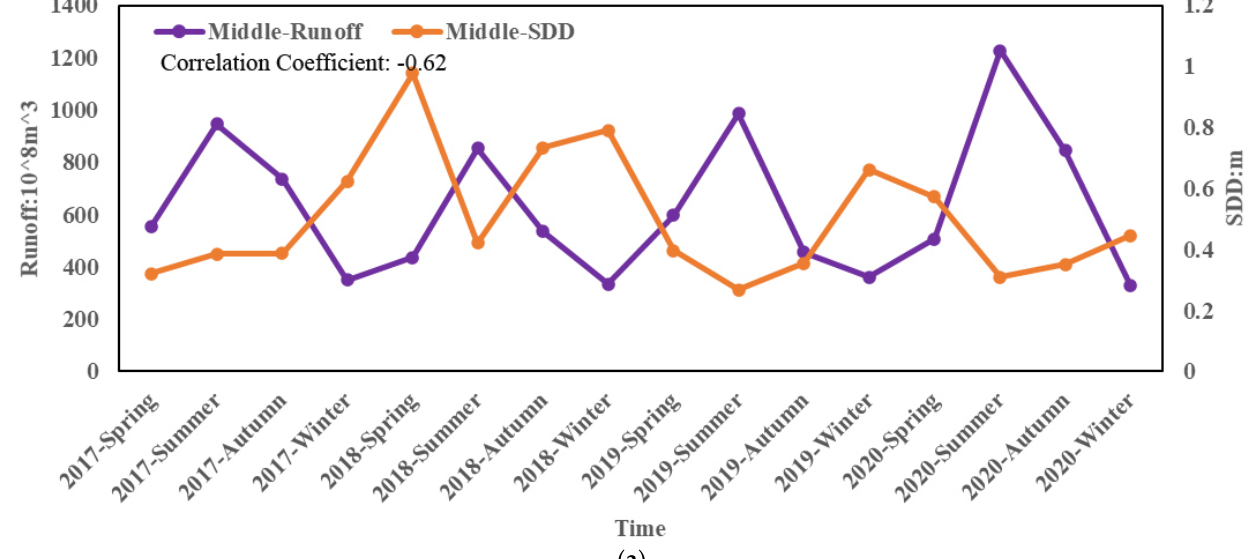
Figure 10. The relationship between the upper reaches of the Yangtze River and runoff, water level, PRCP; ( a ) the rela- tionship between the SDD and runoff ; ( b ) the relationship between the SDD and water level; ( c ) the relationship between the SDD and PRCP.